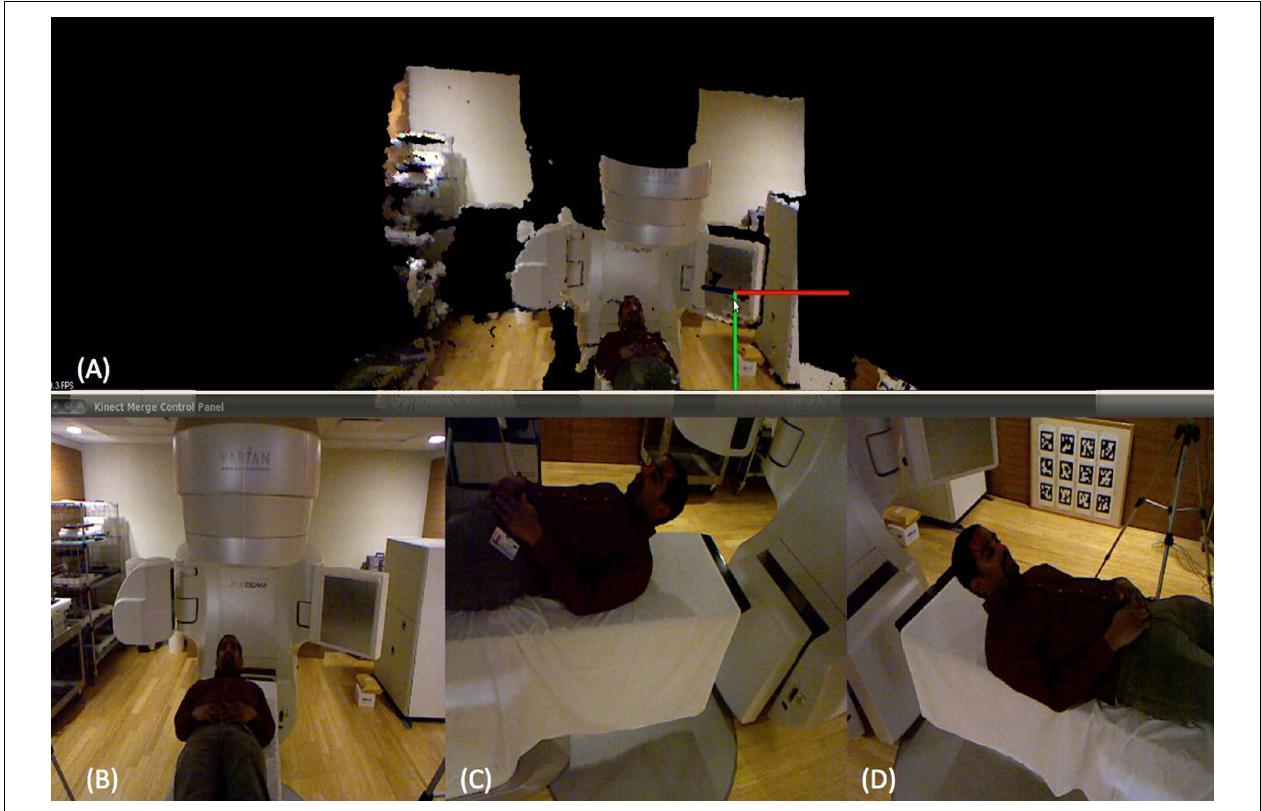
FIGURE 5 | 3D head and neck surface acquisition at the server side in a normally lit environment. The 3D rendering at the client side is shown in (A) while the three 3D cameras at the server side are shown in (B) , (C) , and (D) .